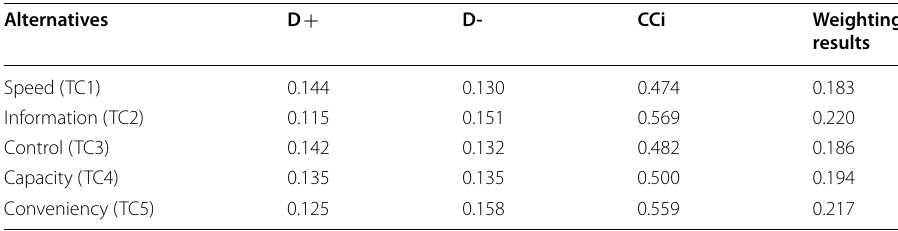
Table 8 Analysis results for the phase 1 of